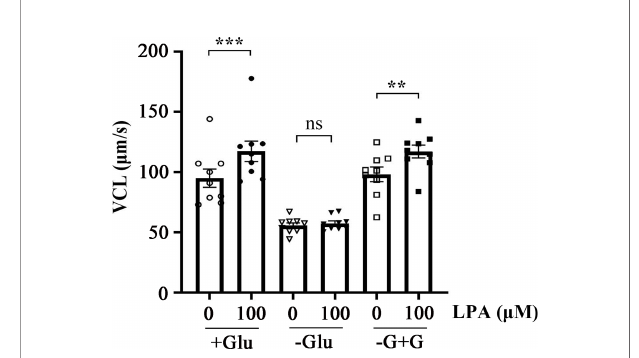
FIGURE 3 | Lysophosphatidic acid (LPA)-induced increase in sperm motility is dependent on glucose in the medium. Spermatozoa were treated with 100 µM LPA for 1 h in the absence or presence of glucose in the medium. Results are expressed as mean ± SEM ( n = 9). ** p < 0.01, *** p < 0.001 as compared with the corresponding control (0 µM). Glu: glucose; -G+G: Glucose was added to the medium without glucose for 15